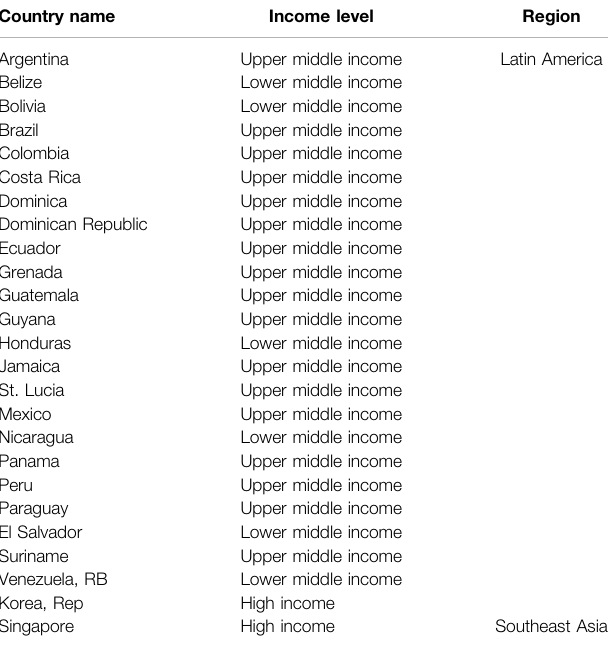
TABLE 1 | List of selected countries with income level and